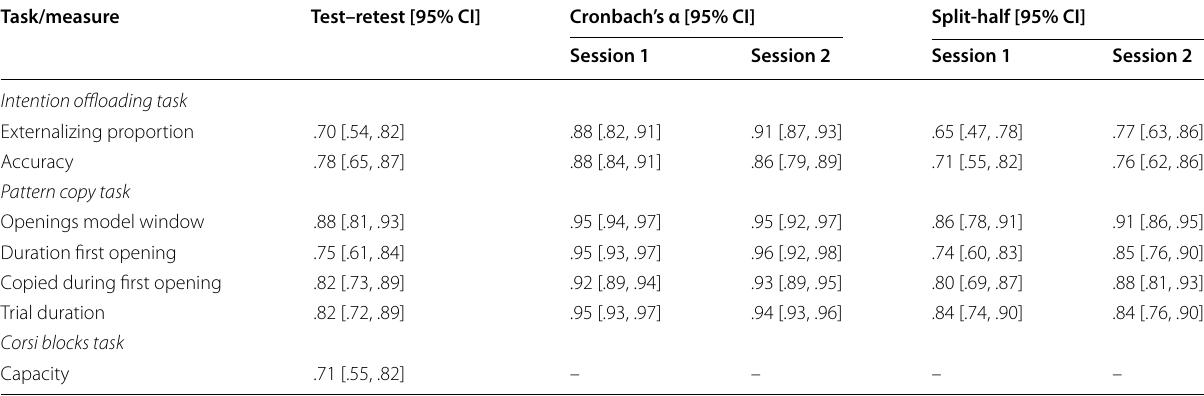
Table 3 Results of the reliability